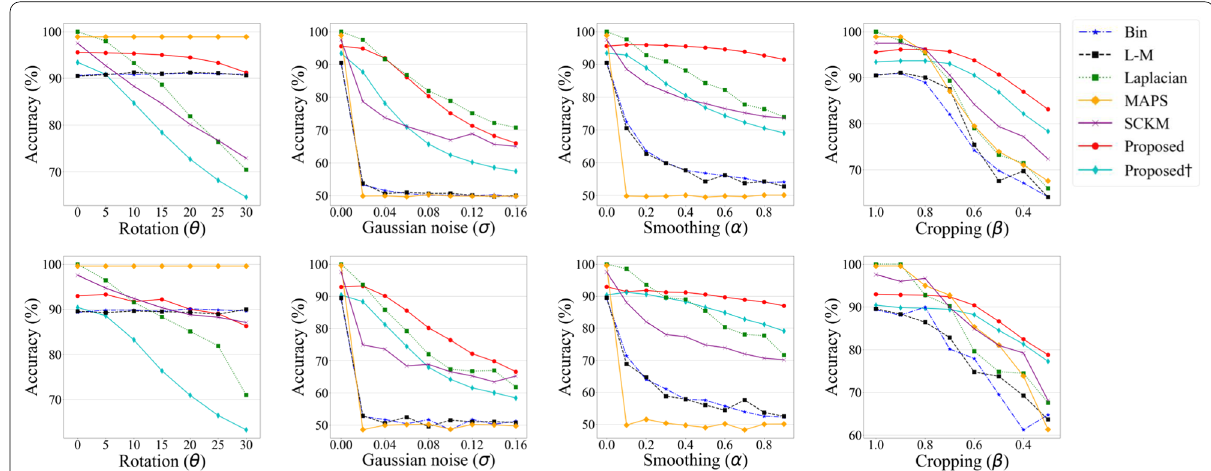
Fig. 7 Bit accuracy rate (%) under different attacks and intensities on Asiadragon (top) and Hand (bottom) dataset. Proposed (red), Proposed † (cyan, † denotes training without the attack layers), Bin Cho et al. (2007) (blue), L-M Bors and Luo (2012) (black), Laplacian Cayre et al. (2003) (green), MAPS (Liu et al. 2017) (orange) and SCKM (Lee et al. 2021) (purple) are showed